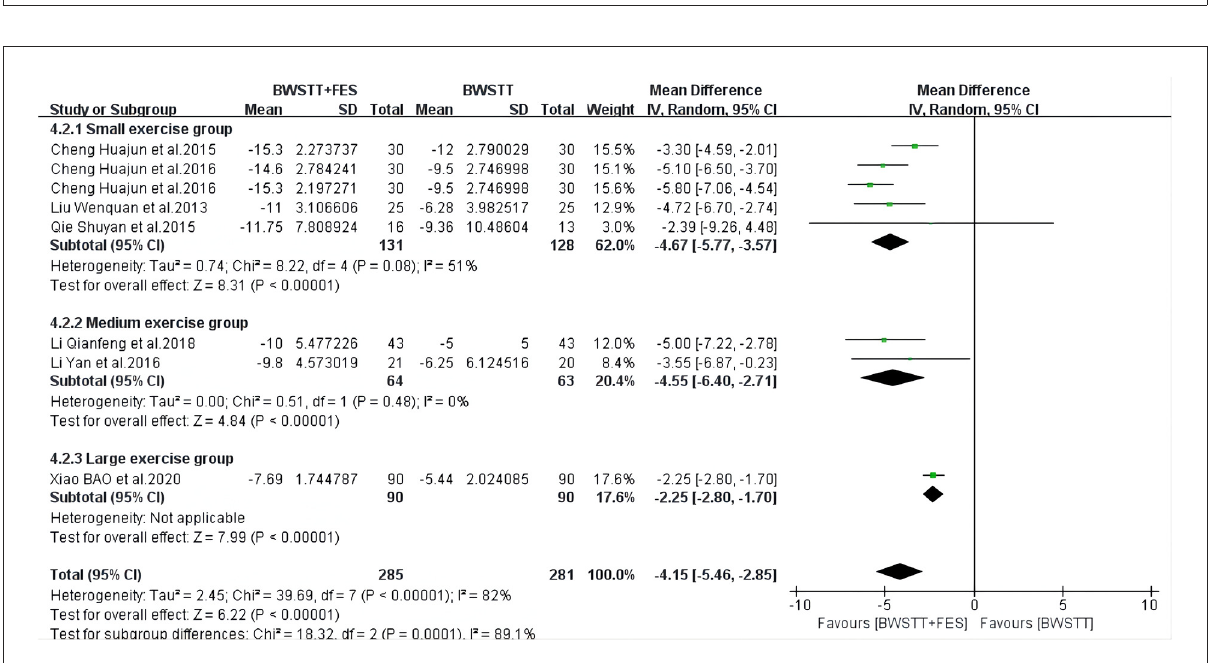
exercise group was similar to that of 10MWT (Figure 5). p < 0.00001) (Figure 7), and FAC ( I 2 = 50%; p = 0.0001)